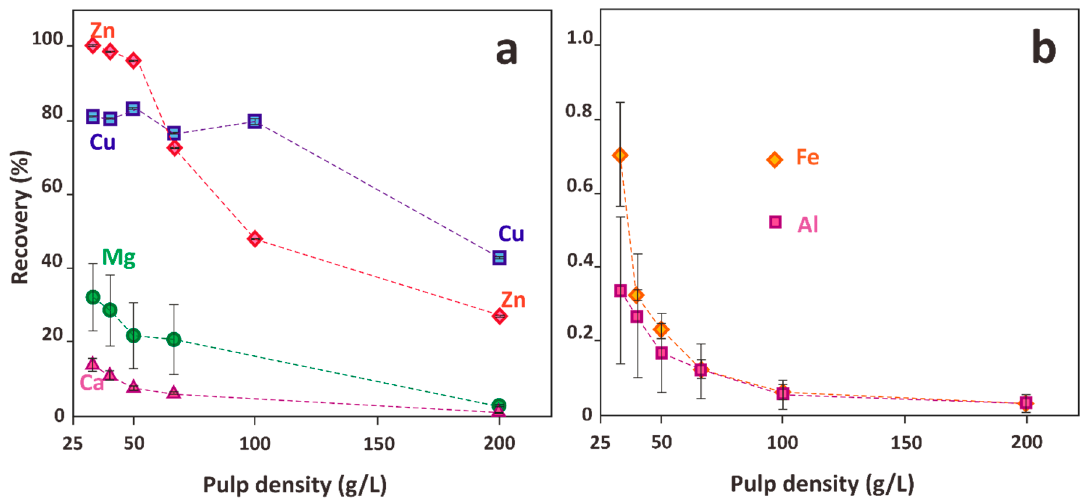
Figure 8. The recovery of ( a ) Zn, Cu, Mg and Ca and ( b ) Fe and Al as function of pulp density.